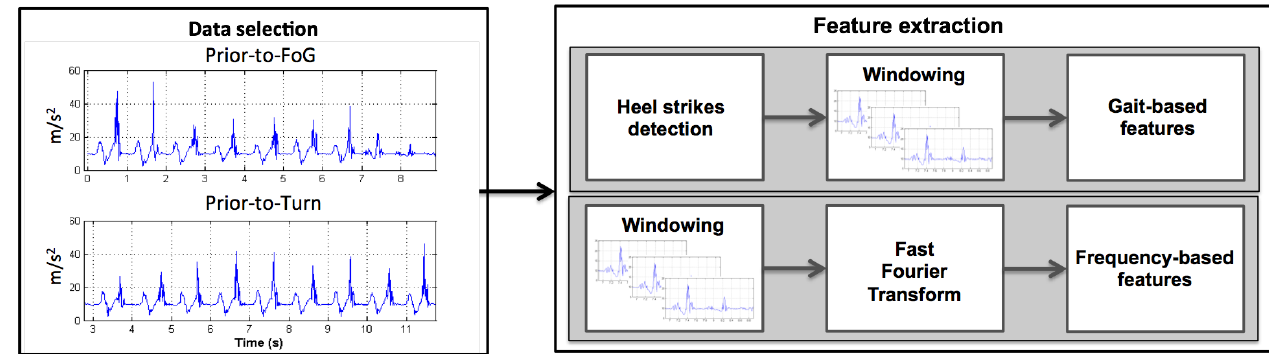
Figure 1: The data analysis framework: In the first phase we select the IMU data from prior-to-FoG and prior-to-turn sessions for each of the 5 subjects. Then, for each session we follow different procedures in case of the two types of features: (1) For gait parameters, we perform a heel strike detection, then we separate the session into 2 seconds non-overlapping windows. From each window we the extract the features. (2) For frequency features, we separate the session into 4 seconds overlapping windows, with a window-overlapping step of 2 seconds, on which we perform a Fourier Transform, and extract the frequency properties.